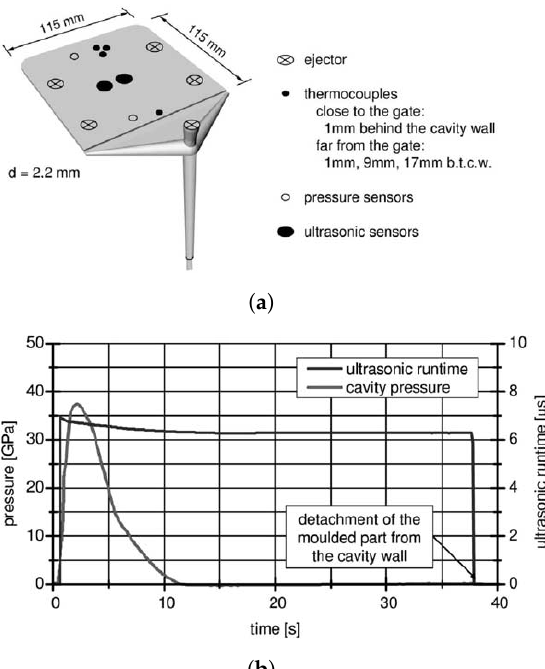
Figure 4. ( a ) Location of the thermocouples, pressure sensors, and ultrasonic sensors at the moulded part; ( b ) Comparison of Ultrasound echoes and pressure sensor